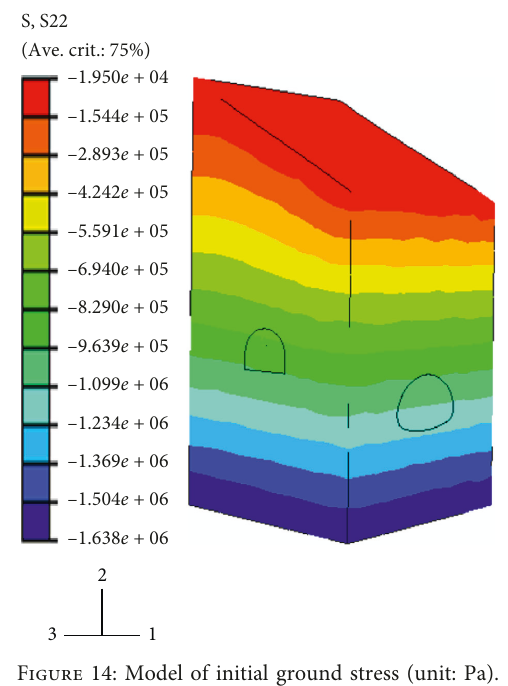
Figure 14: Model of initial ground stress (unit: Pa).